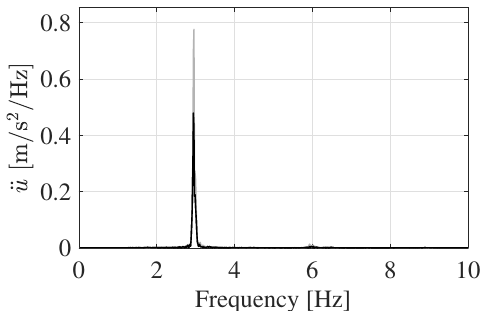
Figure 13. The amplitude spectrum of the vertical structural accelerations measured (black) and simulated (gray, P 50 ) at midspan during subtest 4 of test 1.